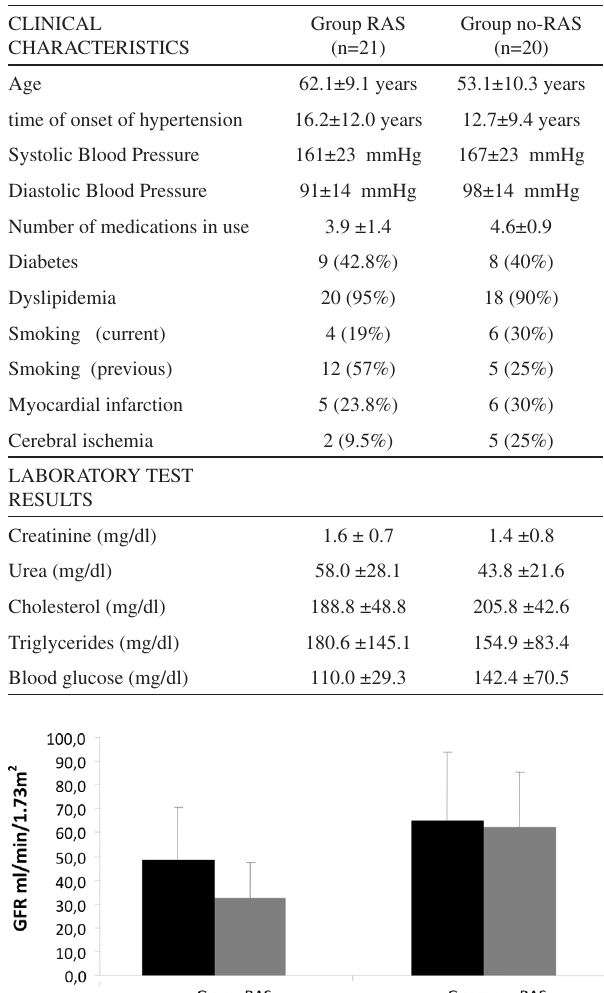
Table 1 - Clinical and laboratorial characteristics of patients in Groups RAS and no-RAS. CLINICAL